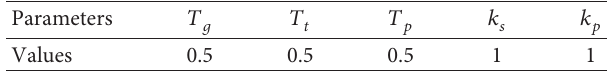
f and Δ ψ t . Table 2: Values of system